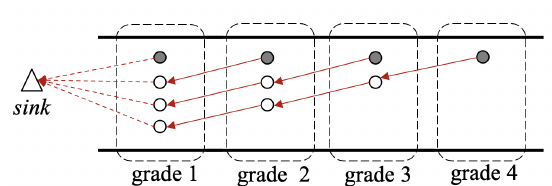
Figure 1. The topology of the network with a total of 4 grades. Note that each red solid-line arrow indicates the packet transmitting route of a non-grade-one node recorded in its routing table, and each red dotted-line arrow indicates the route of a grade-one node.